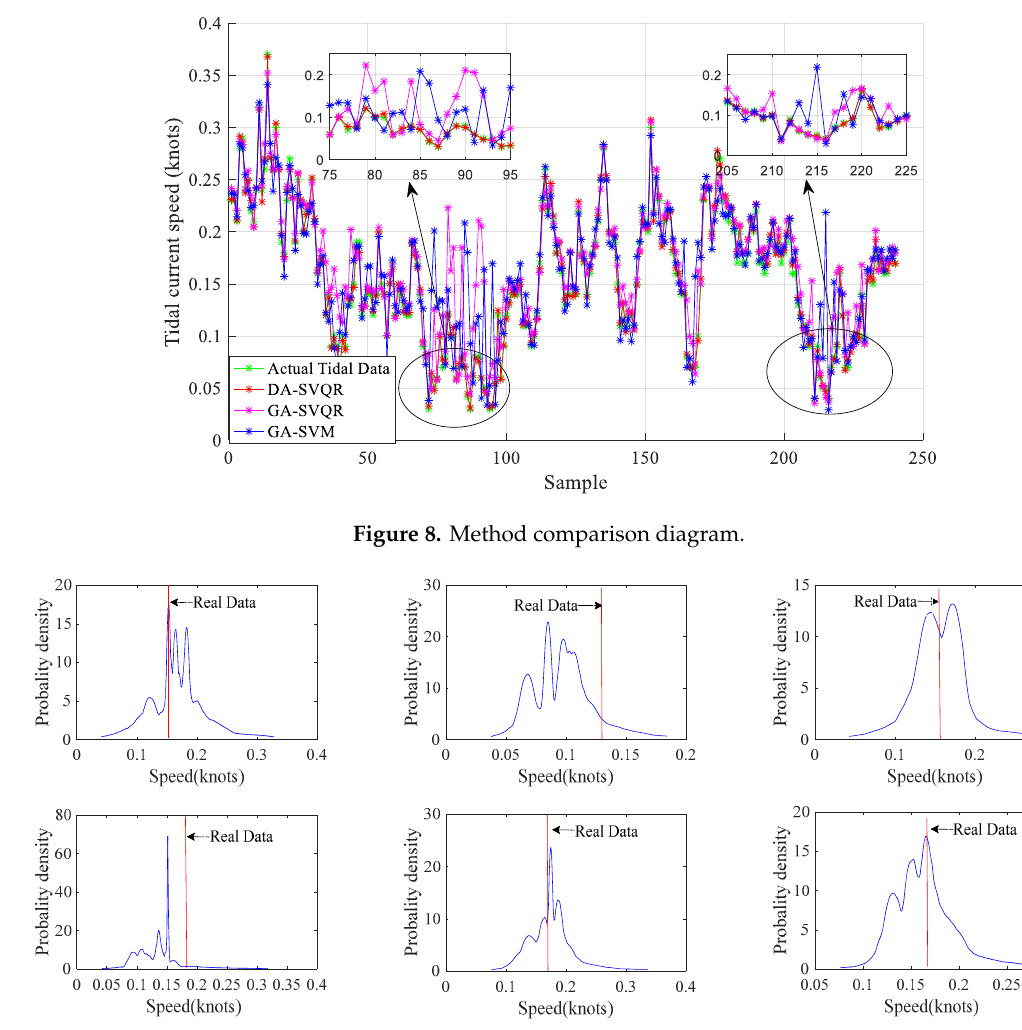
Figure 9. Diagram of the probability density curve.